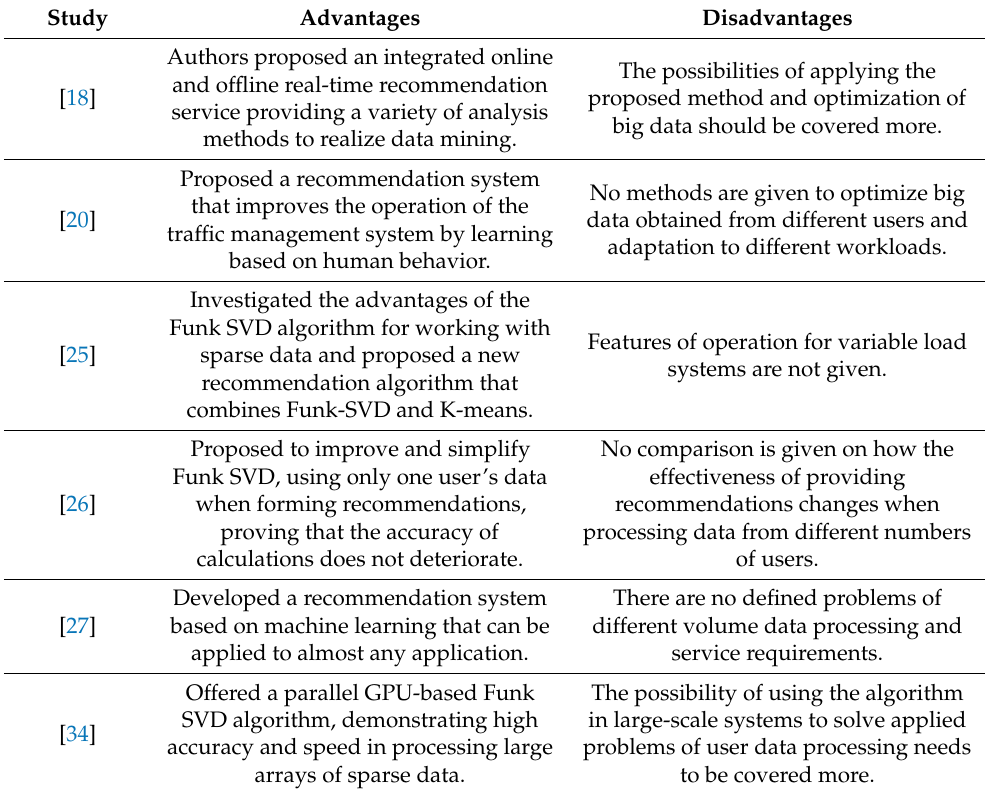
Table 1. Comparison of the most recent studies of big data processing in recommender